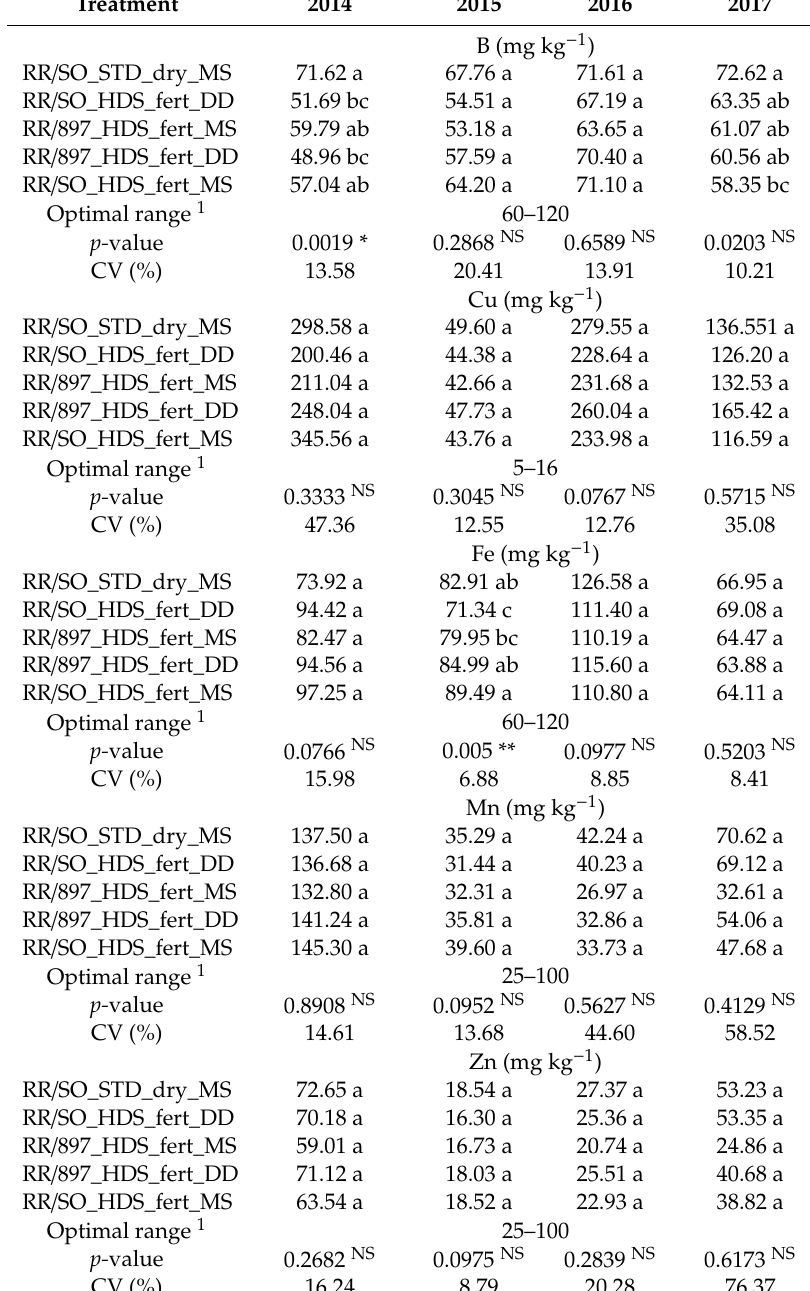
Table 2. Foliar micronutrient concentration of “Ray Ruby” grapefruit (RR) trees as a function of treatments applied during the experimental period